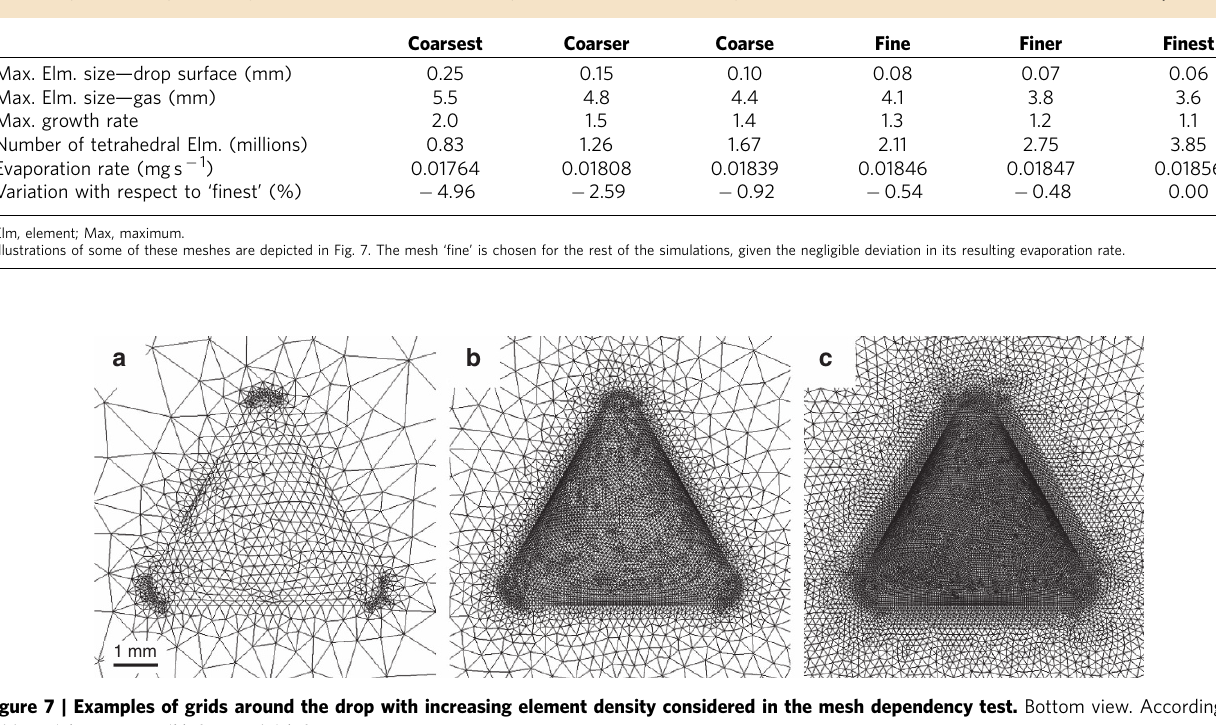
Table 1 | Mesh dependency test carried out for a drop of ethanol with triangular contact area and P ¼ 15mm and V ¼ 7 l l.